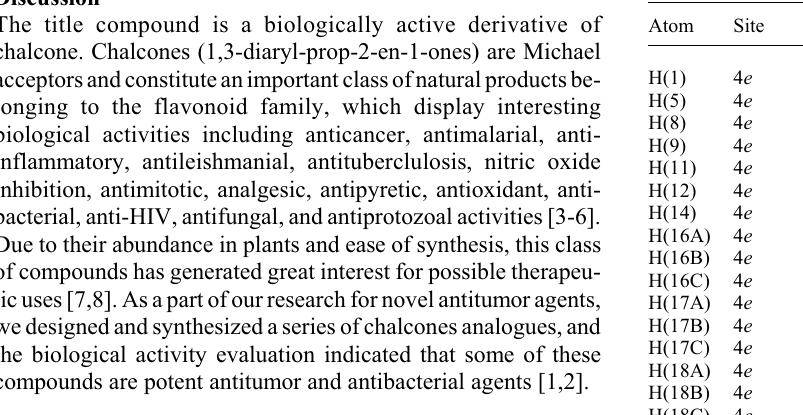
Table 2. Atomic coordinates and displacement parameters (in Å 2 )